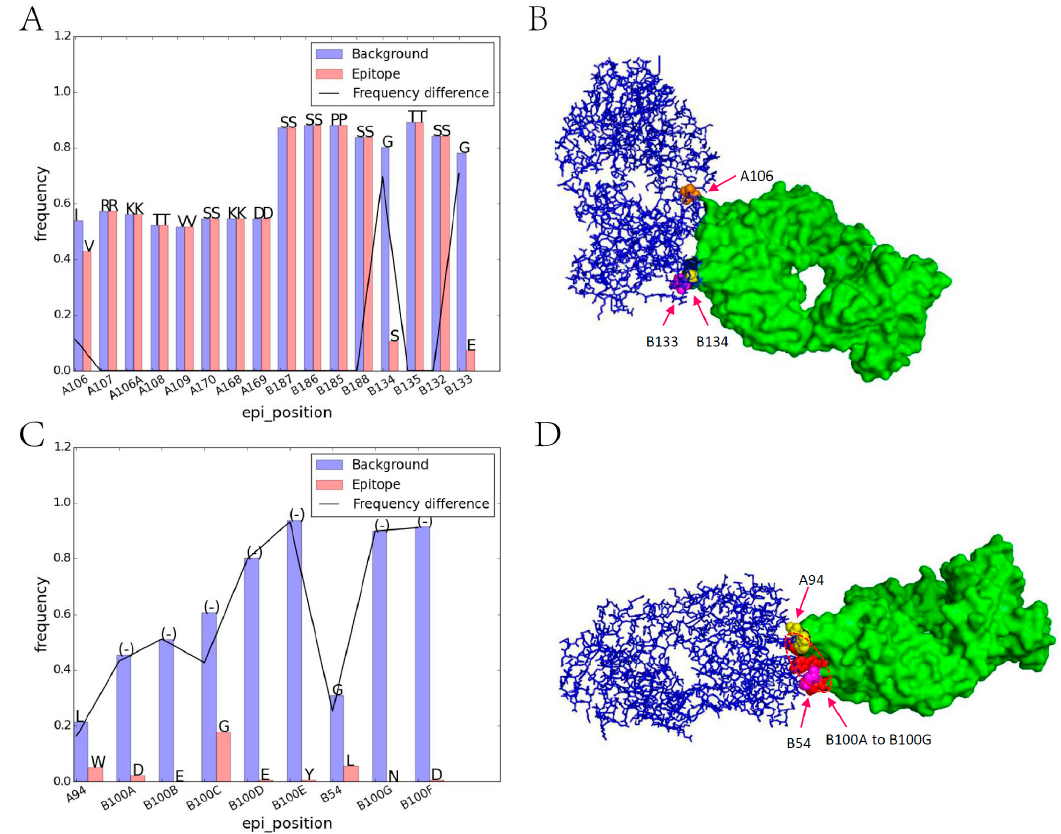
Figure 2. Illustration of amino acid substitution and insertion on iAb epitope regions. ( A ) Residue frequency comparison between iAb epitope (PDB id: 1AD9) and background, letters above each bar represents the abbreviation of different amino acids; ( B ) Corresponding crystal structures of iAb-ADA interactions. iAb is marked in blue while ADA is marked in green. The substitutions in subgraph A are labeled as orange (A106), pink (B133), and yellow (B134) in subgraph B , respectively; ( C ) Residue frequency comparison for 1RZ8; ( D ) Corresponding crystal structures. The residue insertion in subgraph C are marked in red (B100A to B100G) and the substitutions are marked in yellow (A94) and pink (B54), respectively. PDB: protein data bank; iAb: immunogenic antibodies; ADA: anti-drug antibodies.